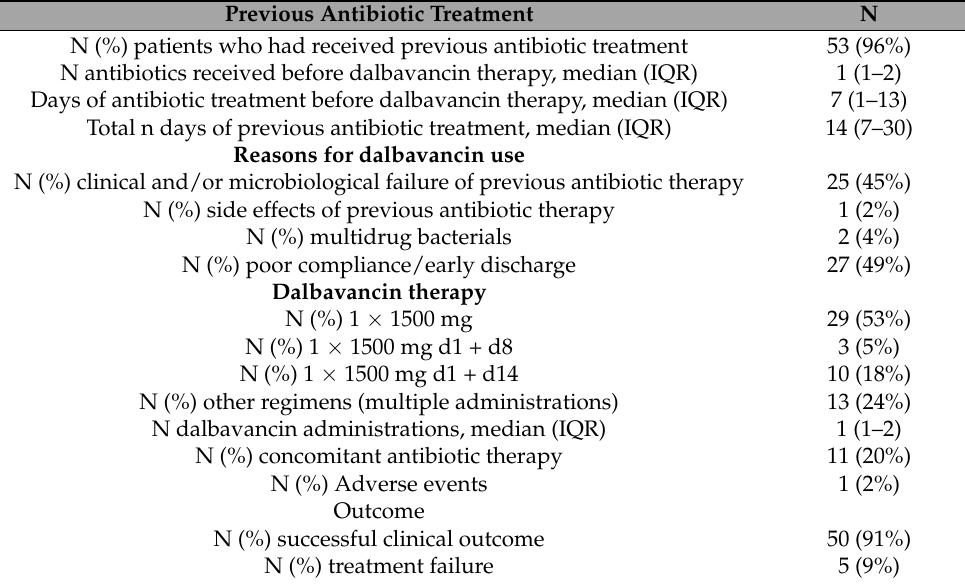
Table 2. Previous antibiotic treatments and characteristics of dalbavancin treatment.